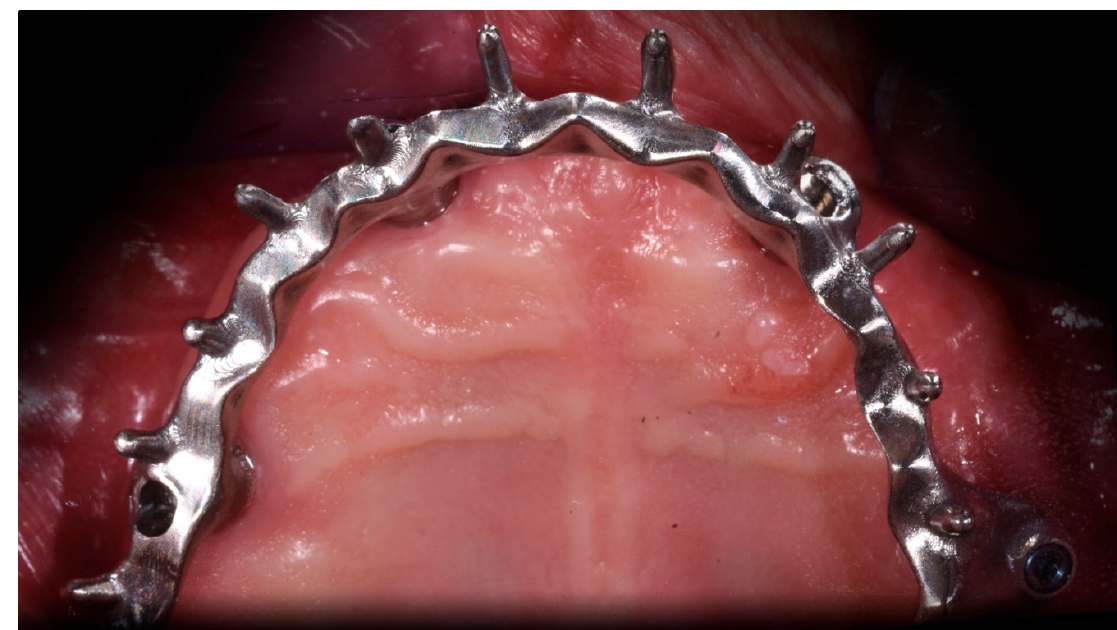
Figure 12. Inserting the Seeger and taking away the carrier.